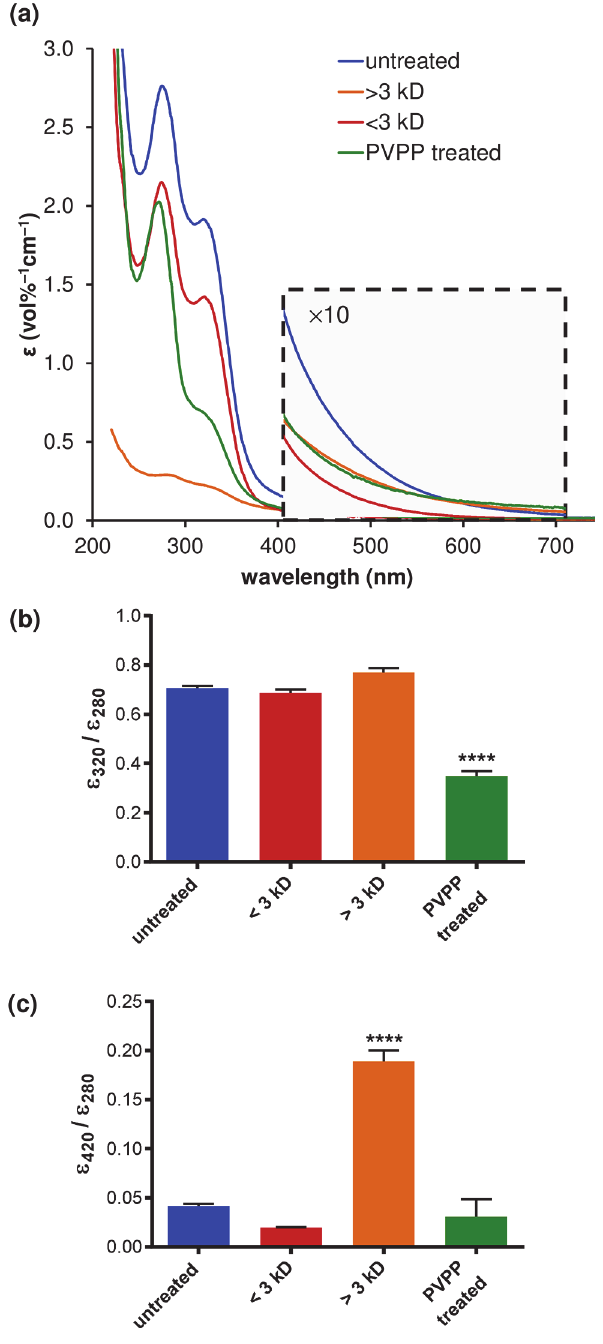
Fig 4. (a) UV-vis spectra of coffee brew following various treatments; quantification at discrete wavelengths associated with (b) total protein and polyphenol content (280 nm, 320 nm) and (c) melanoidins (420 nm). Consistent with a reduction in chlorogenic acid content [3], a significant decrease in the relative absorbance at 320 nm versus 280 nm was observed following phenolic extraction with PVPP, (one-way ANOVA, F = 24.77, P < 0.0001, n = 3; Holm- Š ídák test, **** P < 0.0001 vs. untreated, < 3 kD and > 3 kD). A significant increase in the relative absorbance at 420nm versus 280 nm was also observed in the HMW fraction following 3 kD filtration (one-way ANOVA, F = 57.91, P < 0.0001, n = 3; Holm- Š ídák test, **** P < 0.0001 vs. untreated, < 3 kD, PVPP treated), in keeping with brown color intensity arising from HMW